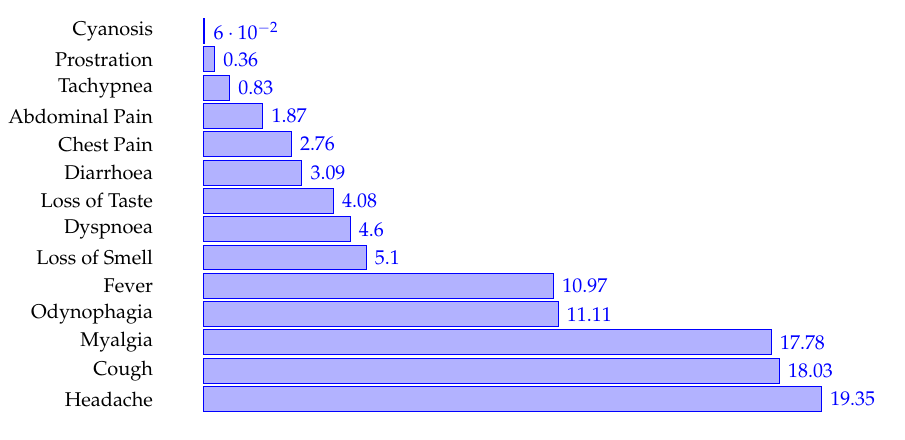
Figure 4. Symptoms